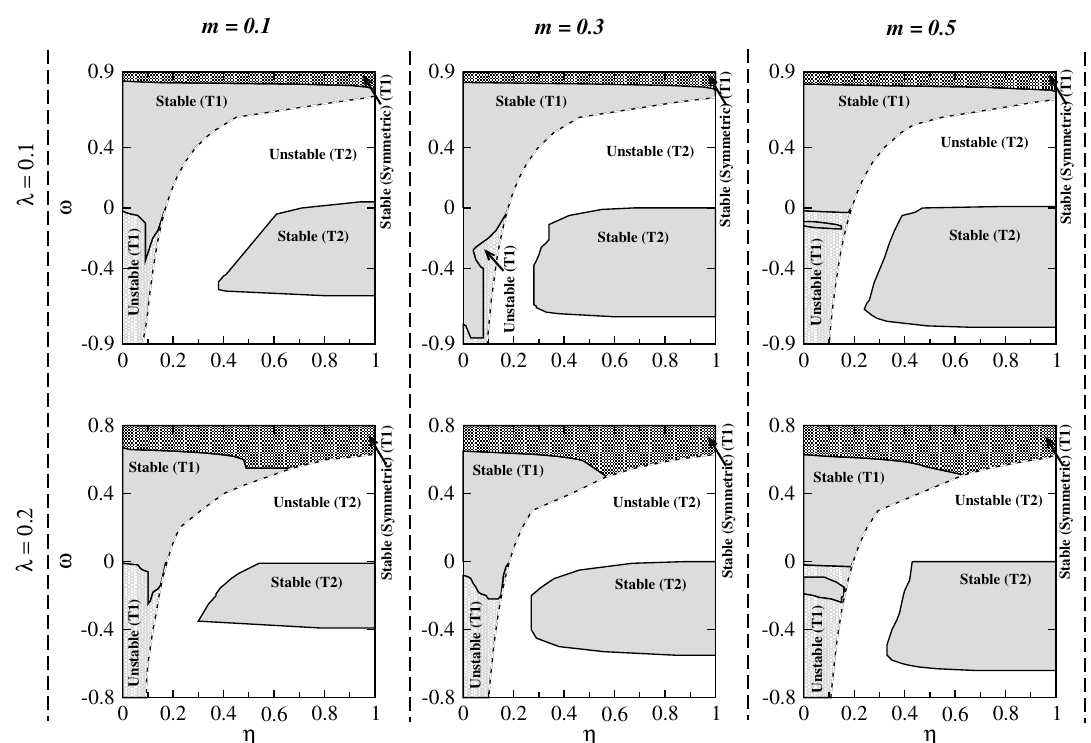
Figure 8. Stability diagrams for asymmetric quiescent solitons for different values of m and λ . The numerically-determined boundaries between Type 1 ( T 1) and Type 2 ( T 2) asymmetric gap solitons are represented by the dashed curves. It should be noted that the solitons in the regions labeled as “Stable (Symmetric) (T1)” belong in the symmetric branch of the bifurcation diagrams where only the symmetric solitons exist (see